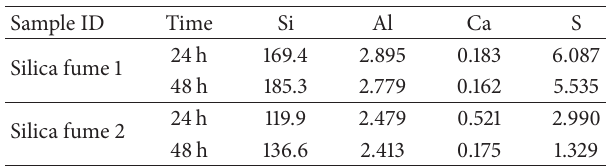
Table 6: Element dissolution concentrations of raw silica fume in NaOH solution (mg/L).